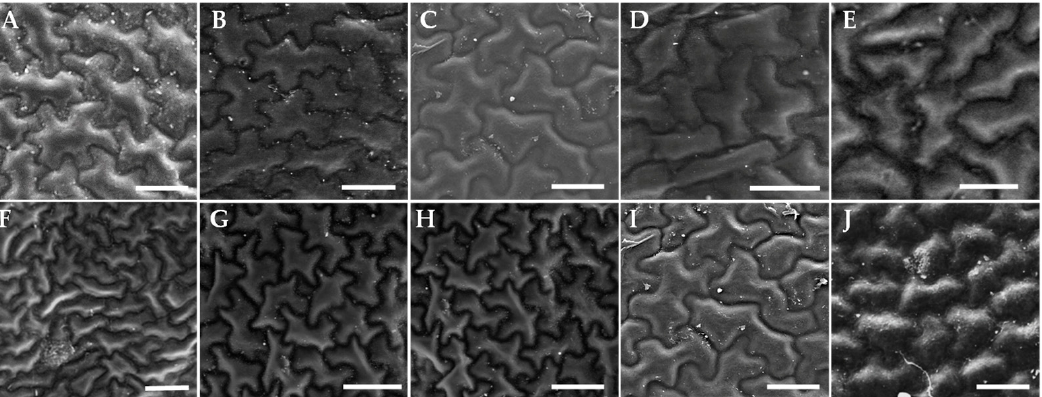
Figure 4. Characteristics of the adaxial epidermal cells under scanning electron microscope. ( A ) P. qiui ; ( B ) P. decomposita ; ( C ) P. jishanensis ; ( D ) P. ostii ; ( E ) P. delavayi ; ( F ) P. lutea ; ( G ) P. potanini ; ( H ) P. rockii ; ( I ) P. ludlowii ; ( J ) P. cathayana . (bar = 50 μ m).